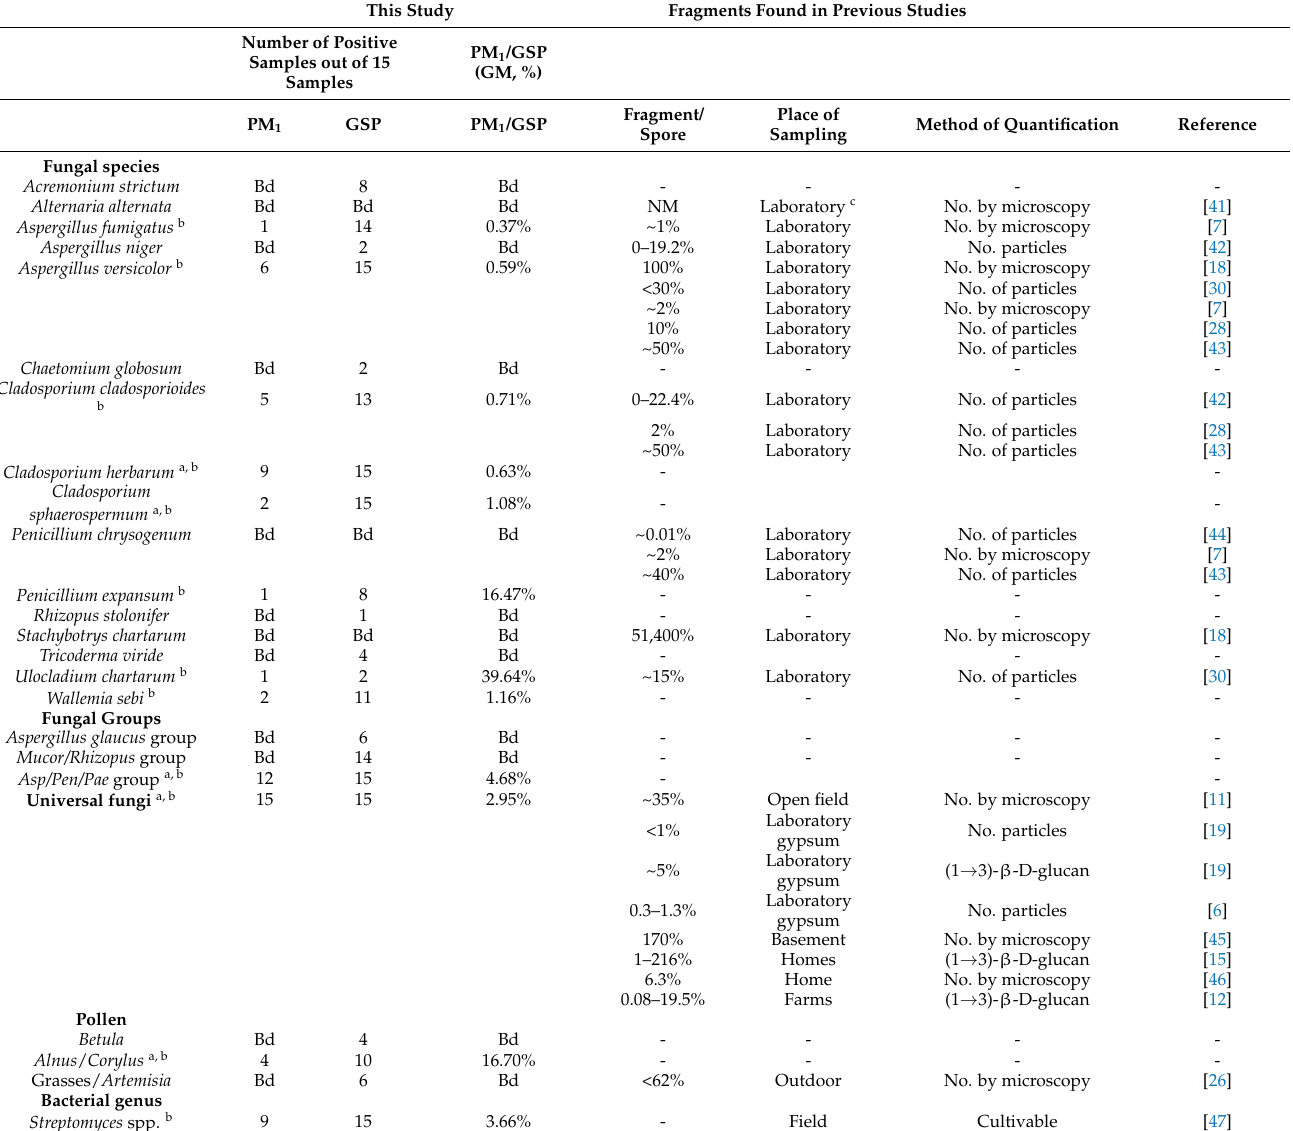
Table 1. The number of positive PM 1 and Gesamtstaubprobenahme (GSP) samples as measured using qPCR; PM 1 /GSP (%); and references to other papers where fragments have also been found using other